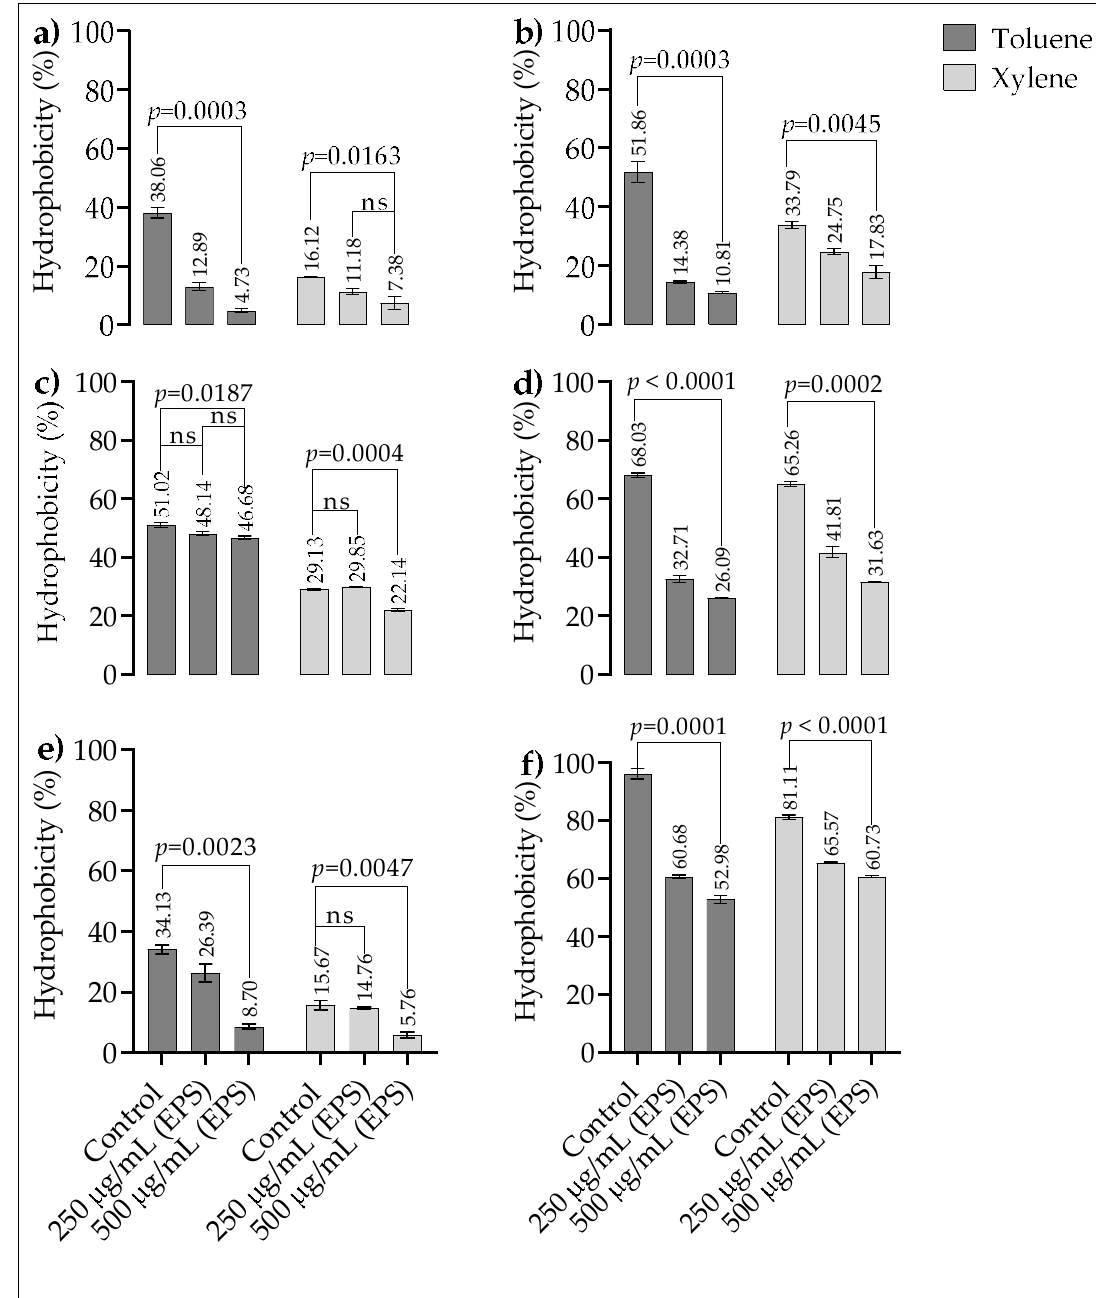
Figure 5. ( a ) P. denticola ATCC 33185. ( b ) P. denticola AHN 33266. ( c ) P. gingivalis ATCC 33277. ( d ) P. gingivalis AHN 24155. ( e ) F. nucleatum ATCC 25586. ( f ) Fil. alocis ATCC 35896. Bars include standard deviation. EPS: exopolysaccharide. ns: not significant.